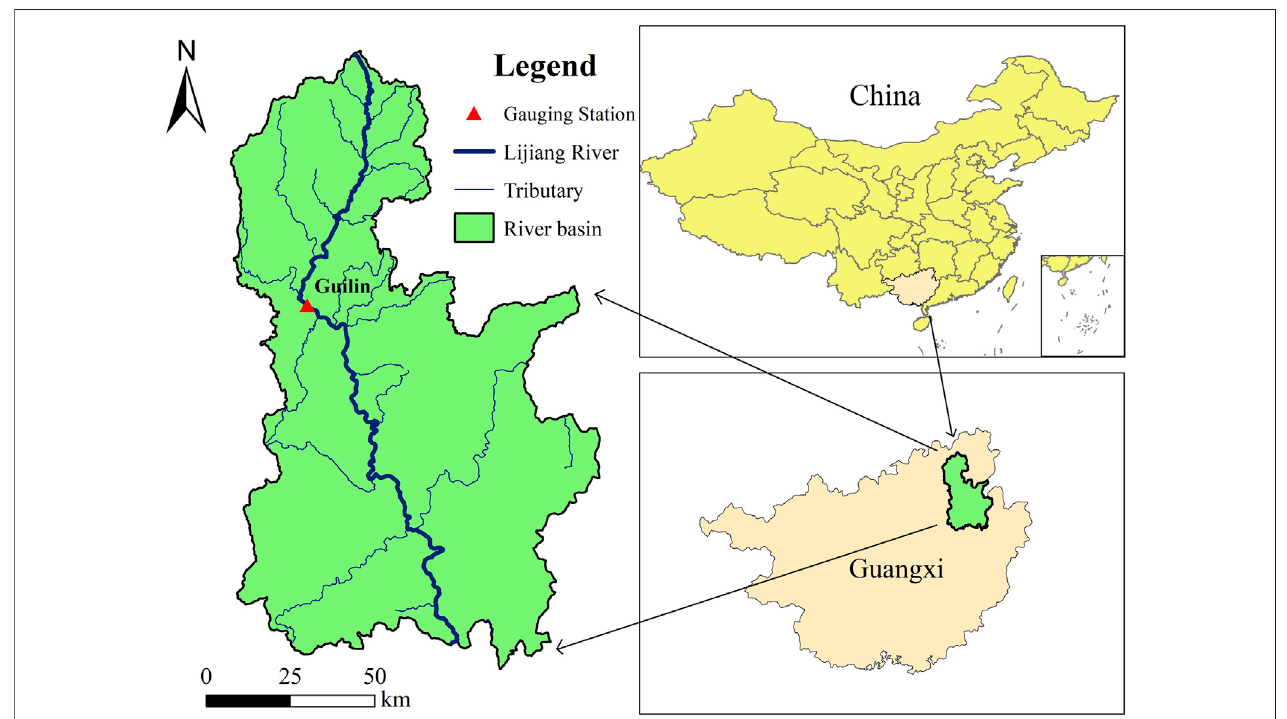
FIGURE 1 | Location of the lijiang river basin and gauging station.